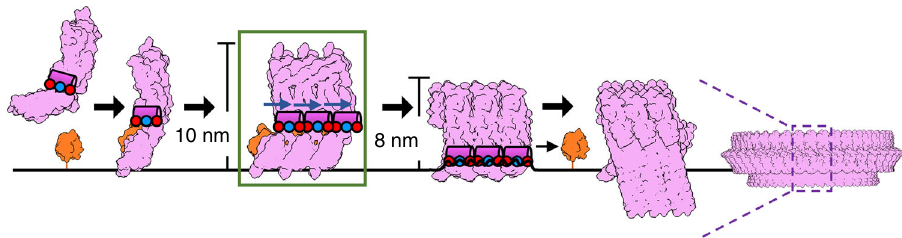
Fig. 5 Model for CDC pore formation and membrane lysis. Soluble monomers (pink) bind target membranes through interactions with either cholesterol or cell surface receptors, such as CD59 (orange). Oligomerization of the membrane-bound subunits (green box) causes structural rearrangements that include a shift (blue arrow) of the amphipathic h-helix (pink cylinder), as captured in our cryoEM reconstruction. The early prepore, which extends 10 nm from the lipid bilayer, collapses to 8 nm and brings the charged face of the h-helix (blue and red circles) into contact with the membrane. The amphipathic h-helix disrupts the membrane, leading to the transition of helical bundles (HB1 and HB2) into membrane-piercing β -hairpins. For ILY, CD59 dissociates, as it is not part of the fi nal pore. Though only three monomers are displayed, this process occurs for higher oligomer arc and ring-like pores 14 . Figure is based on ILY and PLY structures: PDBIDs 6ZD0, 1S3R 54 , 4BIK 17 , 5CR6 15 , and 5LY6 15 ; and EMD-4118